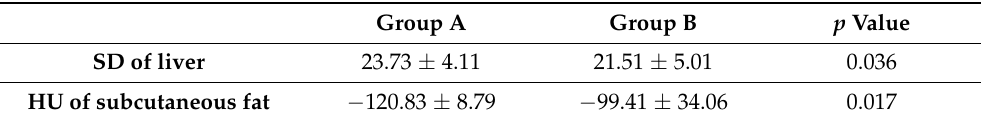
Table 2. Image noise and HU in liver and subcutaneous fat of Group A (dose modulation on) and Group B (dose modulation off).